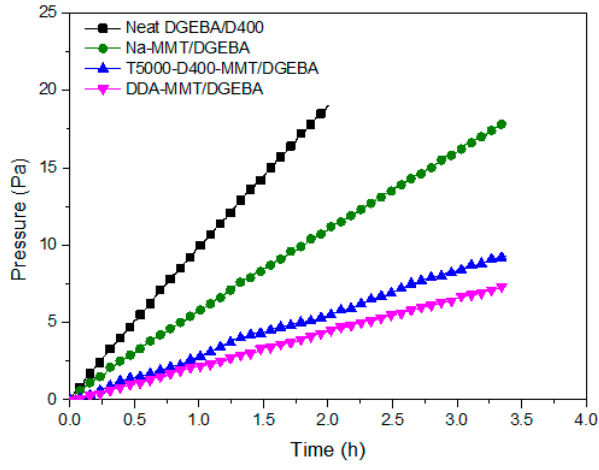
Figure 10. Pressure of permeated N 2 as a function of time through neat DGEBA/D400 epoxy resin and the nanocomposites reinforced by Na-MMT, T5000-D400-MMT and DDA-MMT at 3 wt % clay loading.